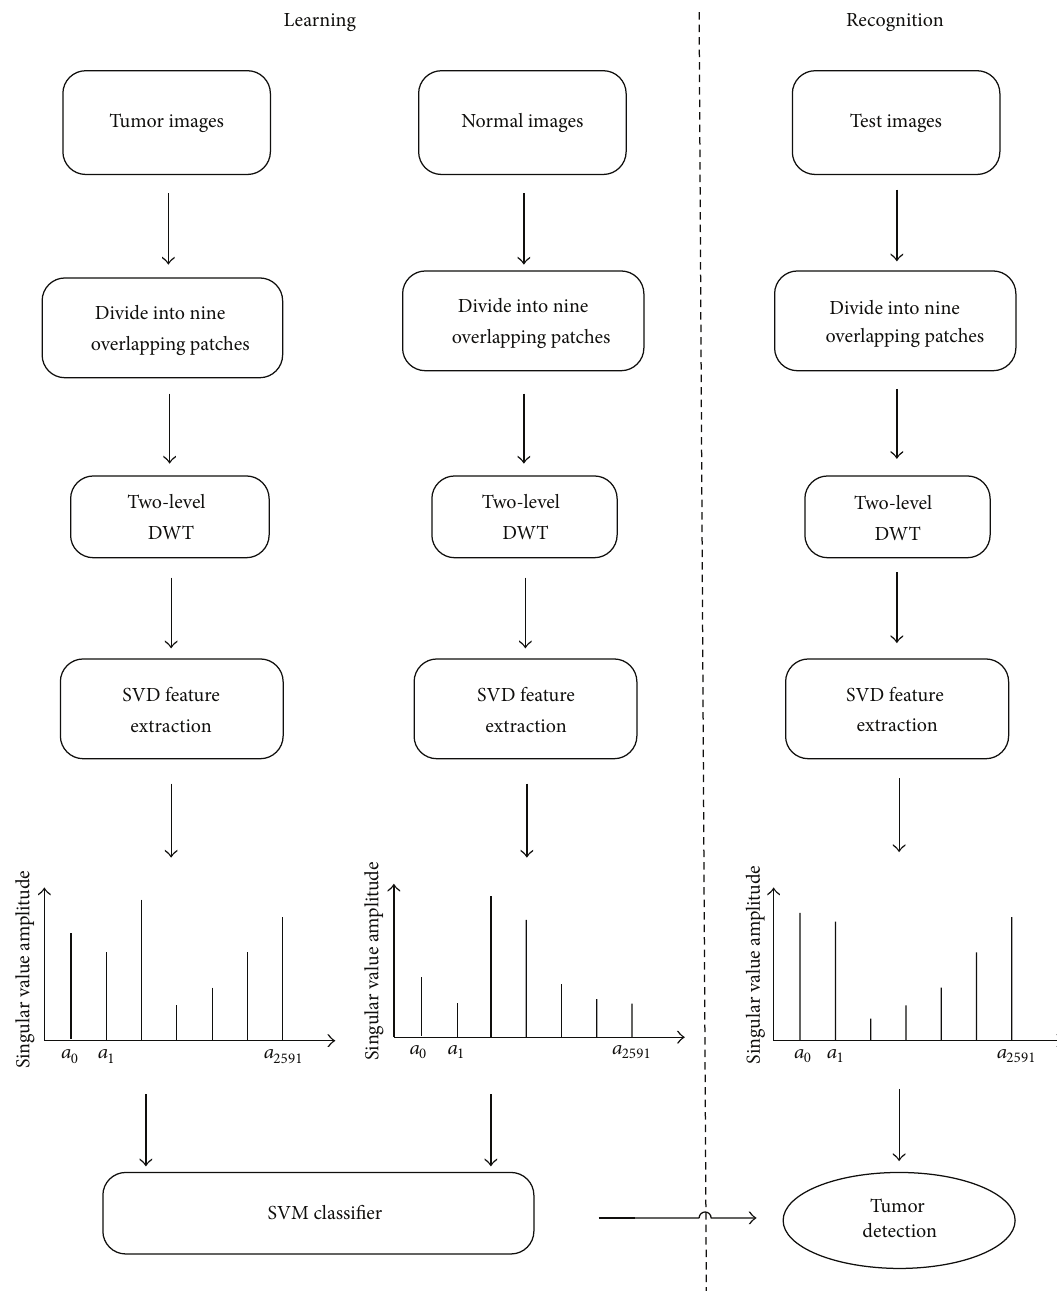
Figure 4: The methodology of the proposed CAD